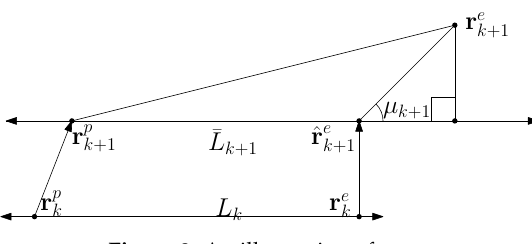
Figure 3. An illustration of µ k + 1 .